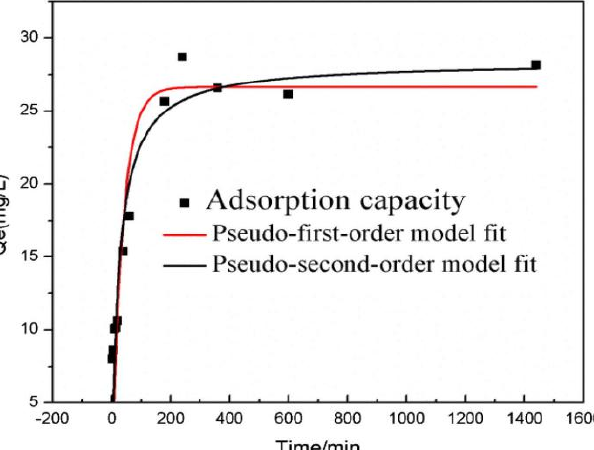
Figure 21. The pseudo-first-order and pseudo-second-order kinetics model fit of As(V) adsorption on MG-CSB (MG-CSB = 20 mg, As(V) concentration = 20 mg/L, pH = 7.3 ± 0.2, t = 4 h, T = 298 K) [40]. Reprinted with permission from Zan Zhou et al. (2016). Copyright 2016,